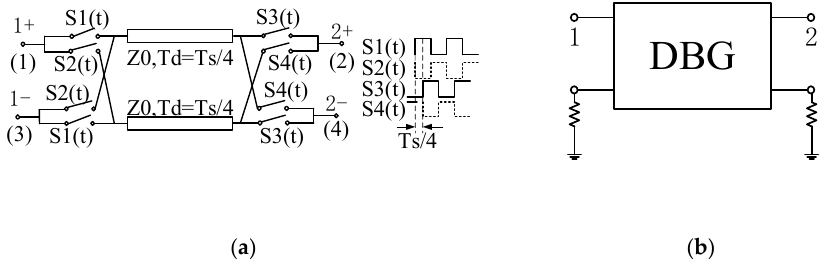
Figure 1. ( a ) Schematic of the doubly balanced gyrator (DBG); and ( b ) schematic of the single-ended transmission isolator (STI).